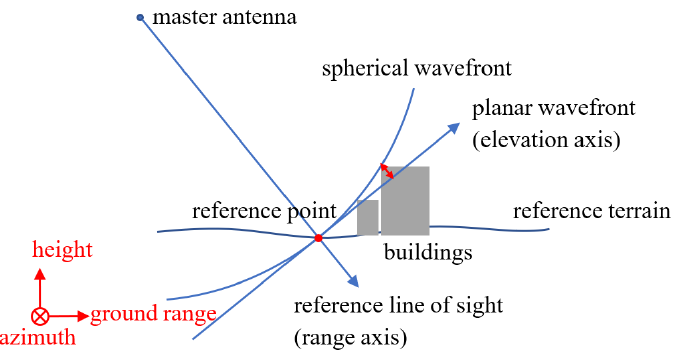
Figure 1. The difference between a planar wavefront and a spherical wavefront in TomoSAR imag- ing geometry.